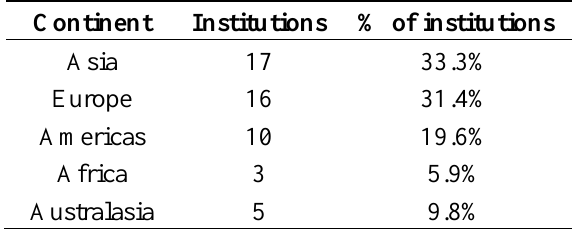
Table 2. The distribution of institutions by